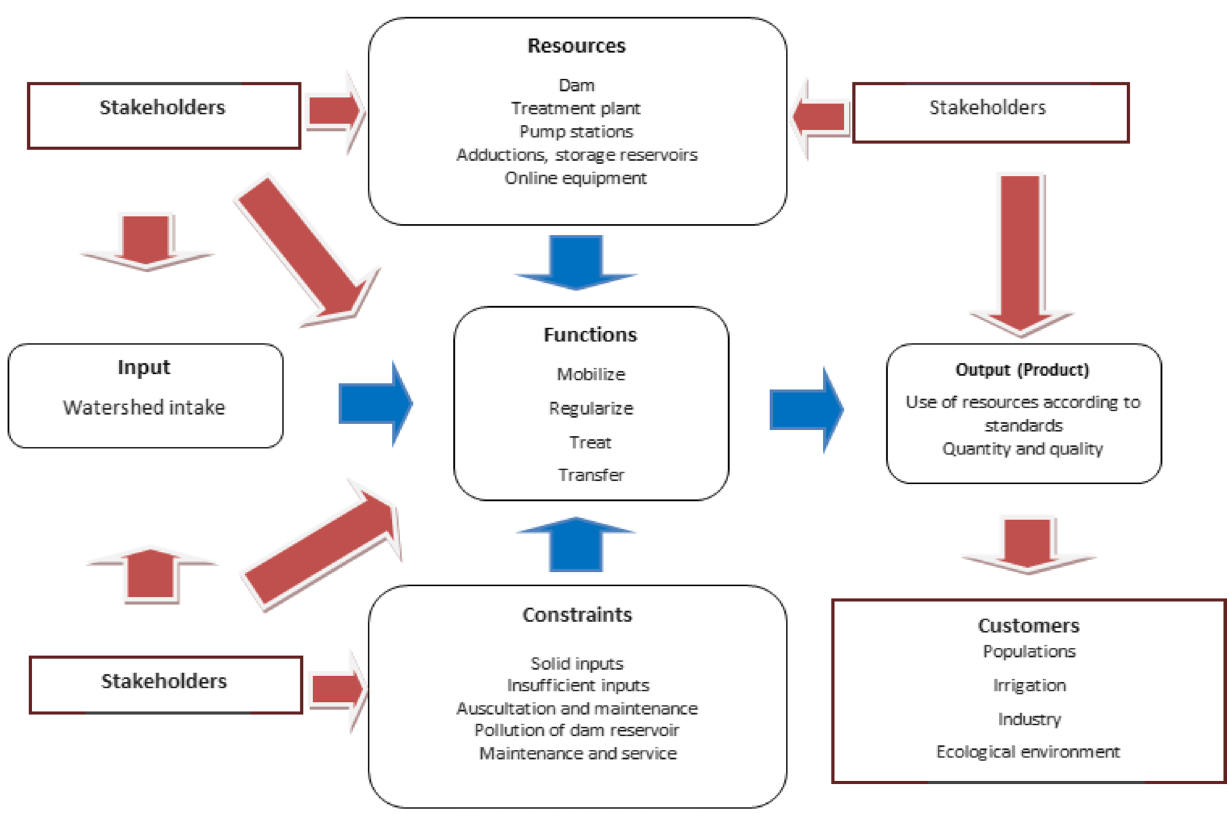
Fig. 3 Conceptualization of Boughrara